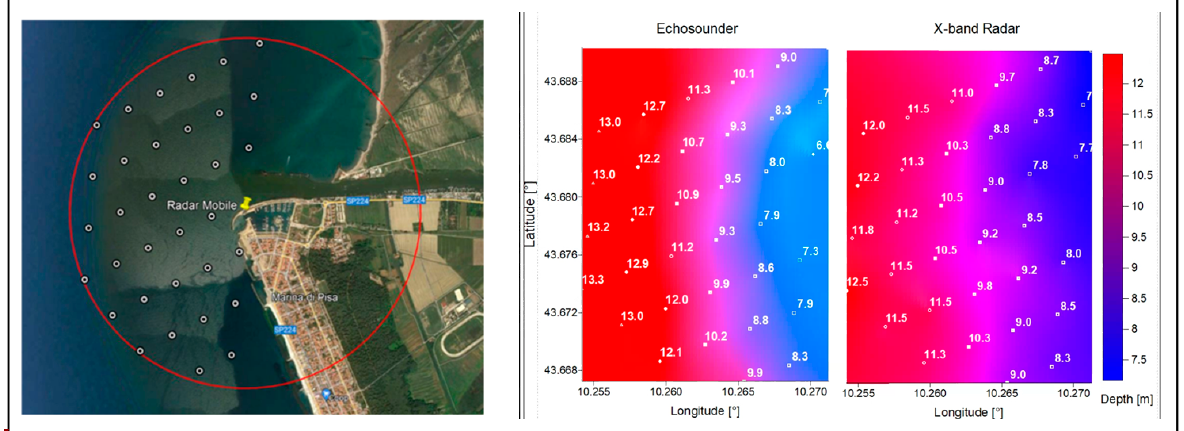
Figure 6. Comparison of bathymetry measurements: the grid points in the survey on the left , the bathymetry obtained by the echo-sounder in the middle, and by Wave Radar measurements on the right .